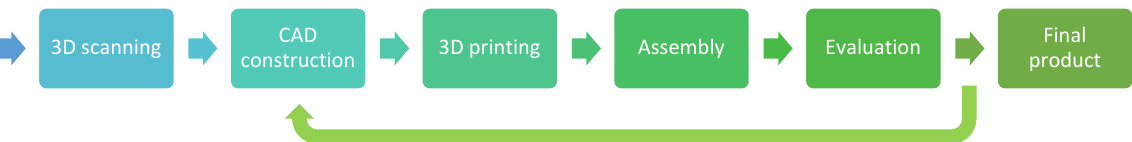
Figure 1. Development process of the myoelectric thumb.